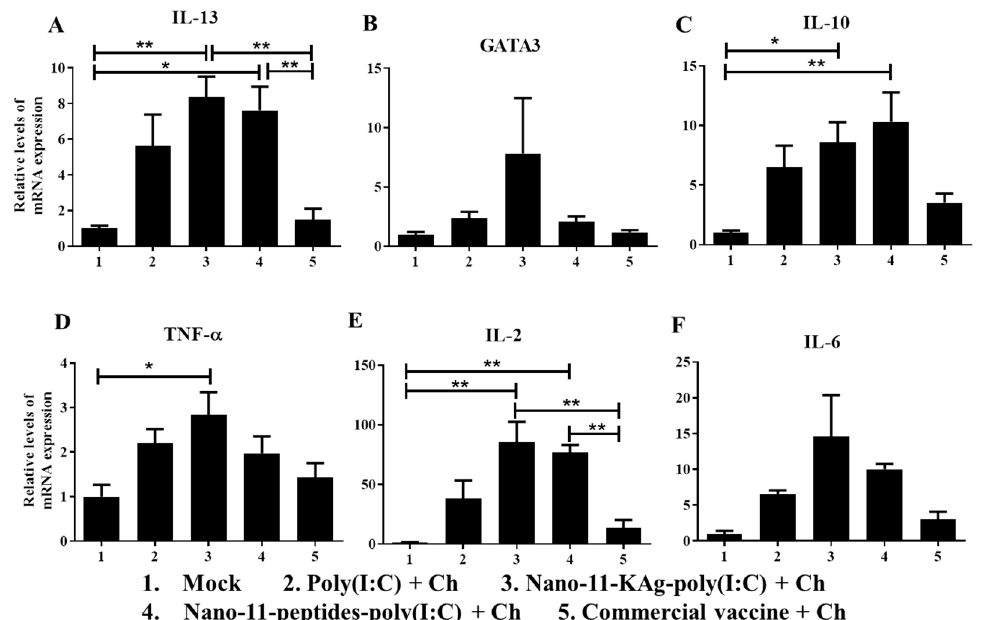
Figure 5. Cytokine and transcription factor mRNA expression in the tracheobronchial lymph nodes of pigs vaccinated with Nano-11 or commercial influenza vaccine and virus challenged. The mRNA expression levels of ( A ) IL-13; ( B ) GATA3; ( C ) IL-10; ( D ) TNF- α ; ( E ) IL-2; and ( F ) IL-6 was determined by qRT-PCR. Data represent the mean value of four to five pigs ± SEM. Statistical analysis was carried out using one-way analysis of variance followed by Tukey’s post hoc comparison. Asterisk refers to statistical difference between the two indicated groups (* p < 0.05, and ** p < 0.01). Ch—Challenge.